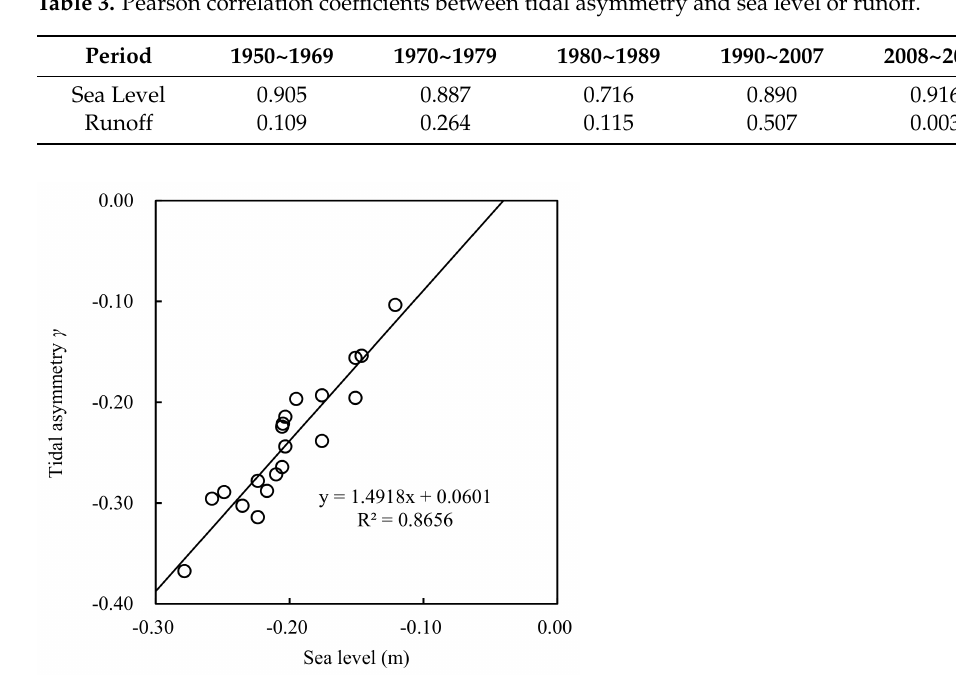
Figure 22. Relationship between tidal asymmetry and sea level from 1950 to